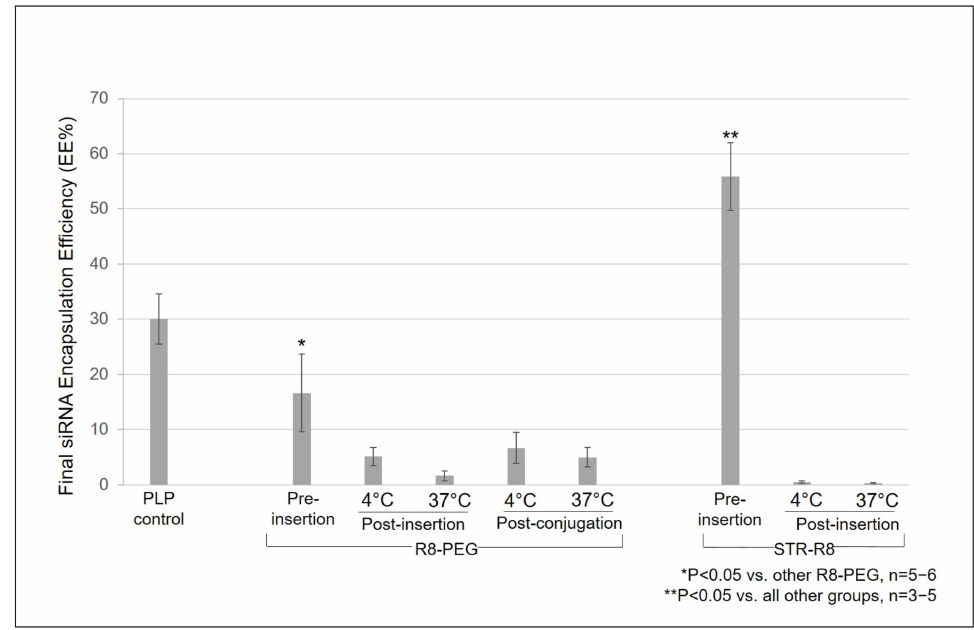
Figure 2. Incorporation of STR-R8 via pre-insertion resulted in the highest siRNA EE% above